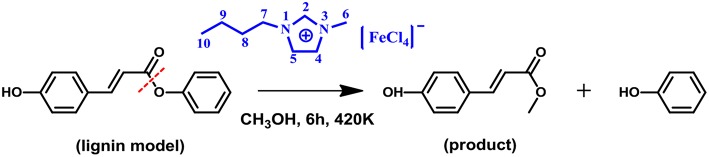
Conversion of lignin model compound to MPC according to Otera (1993) and Hoydonckx et al. (2004).